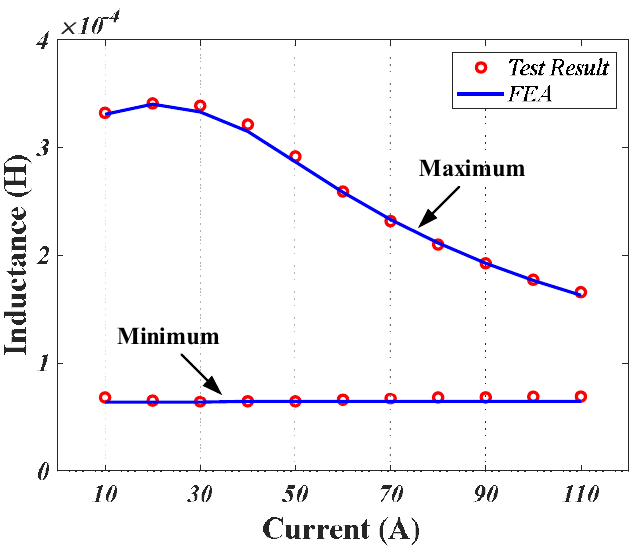
Figure 17. Comparison between measured inductance and those predicted using FEA in the proposed 6/5 SRM.